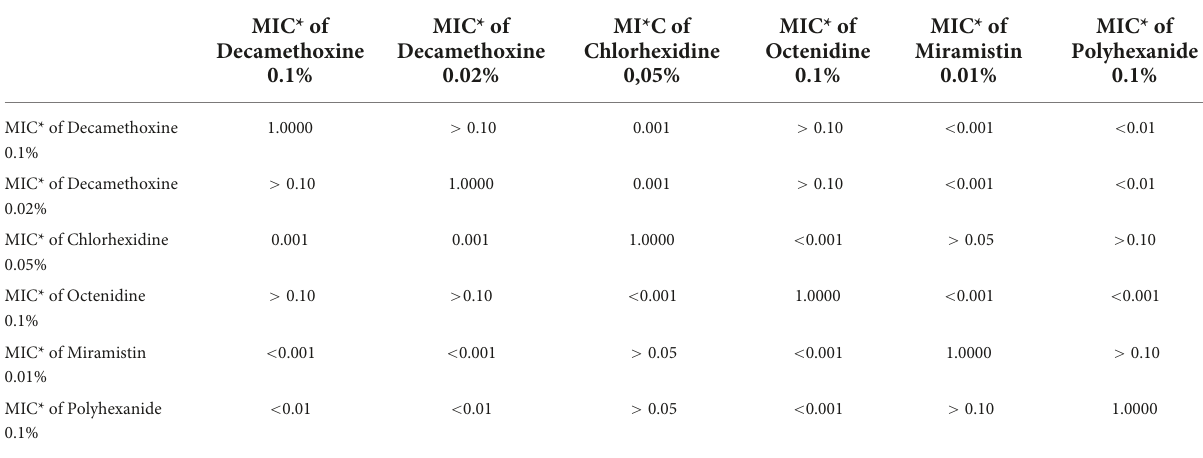
TABLE 2 Coefficients of reliability of the difference between the minimum inhibitory concentrations of the studied antiseptics against clinical strains of A. baumannii (p 1